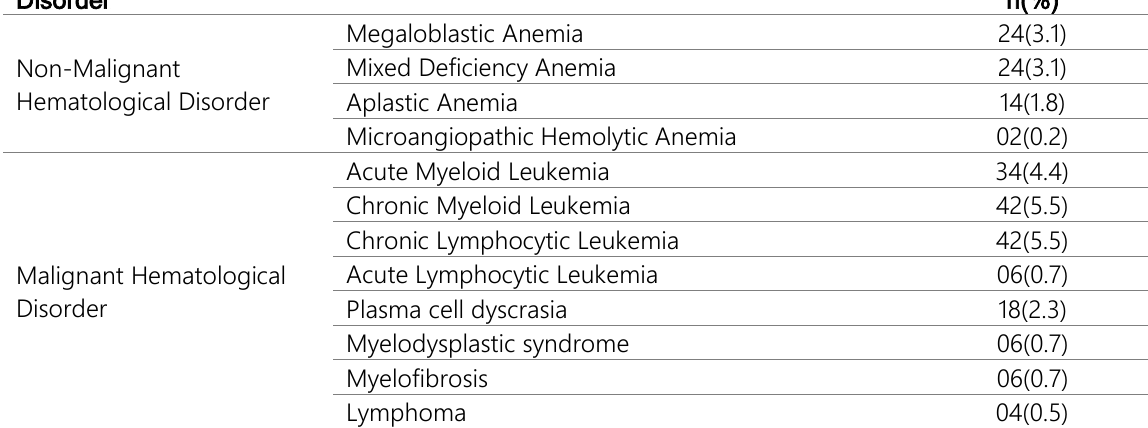
Table 1: Spectrum of non-malignant and malignant hematological disorder